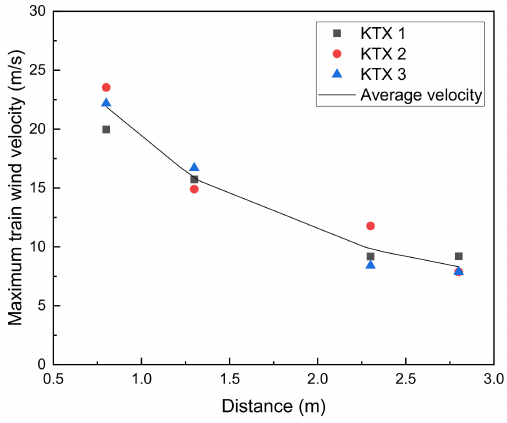
Figure 6. Maximum train-induced wind velocity according to the distance from the train surface during the passage of KTX